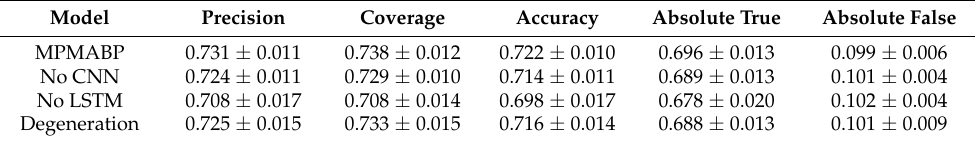
Table 7. The predictive performance of 5-fold cross-validation.